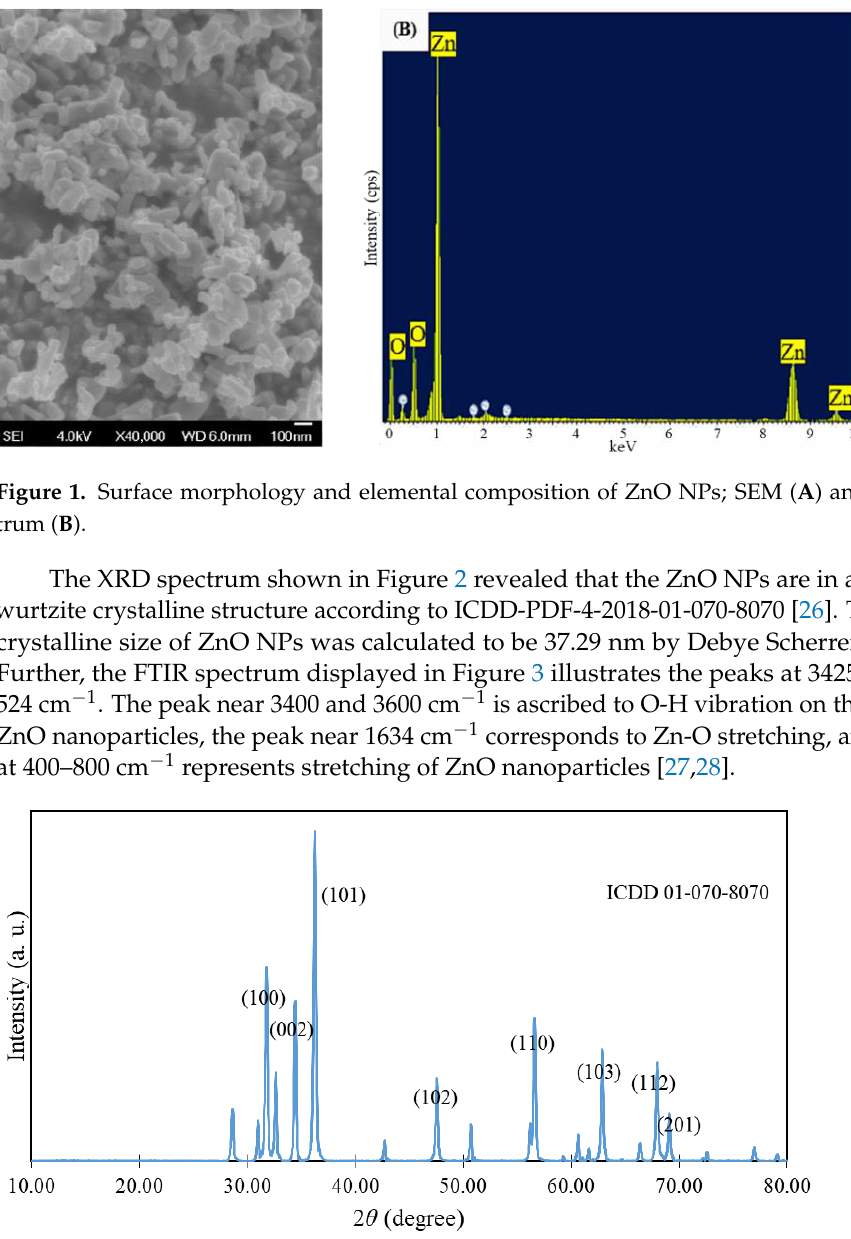
Figure 3. FTIR Spectrum of ZnO NPs. 3.2. Growth Inhibition Test The exposure of yeast cells to the different concentrations of ZnO NPs was performed to report the antifungal effect of ZnO NPs on S. cerevisiae. The present study results showed that the treatment of ZnO NPs on S. cerevisiae resulted in a significant ( p < 0.05) growth reduction at 24 h with the reported values of 7.04 ± 0.64, 18.85 ± 1.92, 33.38 ± 1.35, 40.38 ± 1.81, 61.13 ± 4.89, and 70.30 ± 3.19% for 5, 10, 25, 50, 100, and 150 μg/mL ZnO NPs, respectively (Figure 4). A growth reduction of 88.65 ± 1.49% was reported in positive con- trol treated with amphotericin B (50 µg/mL).